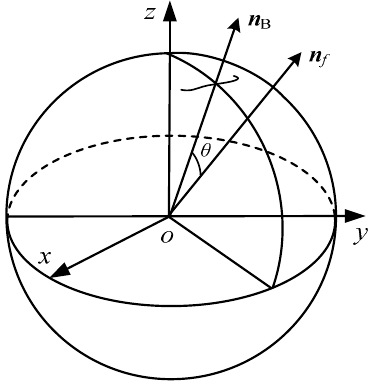
Figure 6. The orientation relationship between the polar axes n f and the target orientation n B .